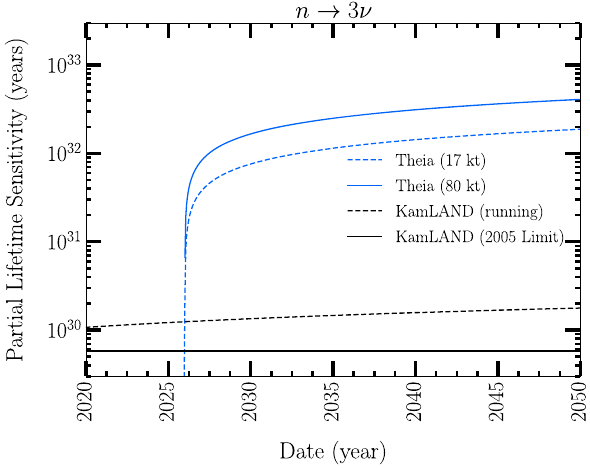
Fig. 21 The large size and depth of Theia means that other next gen- eration detectors are unlikely to be competitive when looking for very low energy modes of nucleon